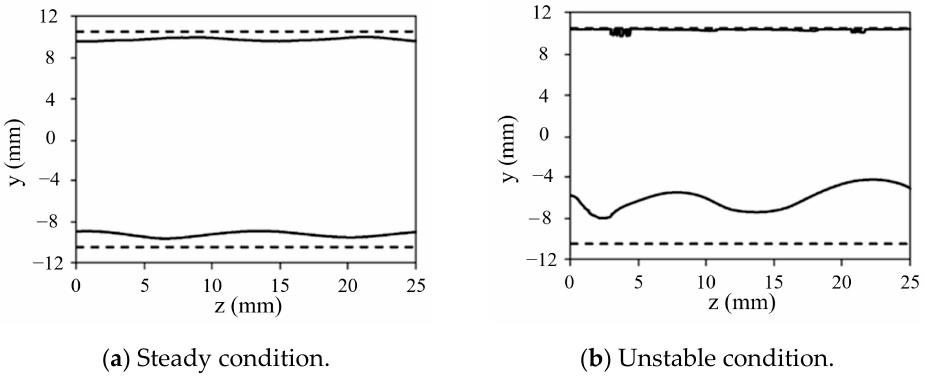
Figure 9. The transition of CAF state [41]. (The dashed line is the wall; the solid line is the interface.) Ooms et al., studied the flow of CAF in a horizontal pipe. The viscosity of the oil was 3300 cP. The paper concerned the equilibrium of buoyancy in the core layer. As shown in Figure 10, the core of the flow model is a solid center whose outer layer is a high-viscosity liquid. The development of interfacial waves was calculated using hydrodynamic lubrication theory. The research shows that the interfacial waves produce pressure changes and generate a net force on the oil core. When the pressure gradient over the pipe is large enough, an equilibrium is formed between the buoyancy force and the hydrodynamic force over the core layer, resulting in an eccentric CAF. As the pressure gradient decreases or the buoyancy force increases, the eccentricity of the core layer increases [42].